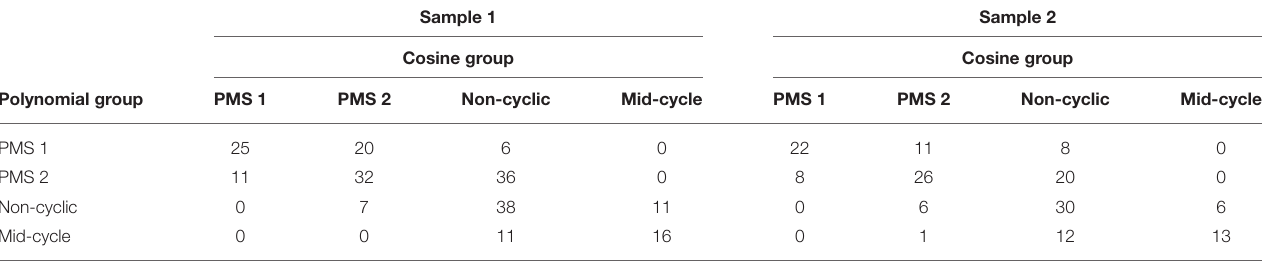
TABLE 3 | Cross tabs of depression/anxiety trajectory groups estimated using polynomial regressions and cosine regressions, presented separately for two samples.